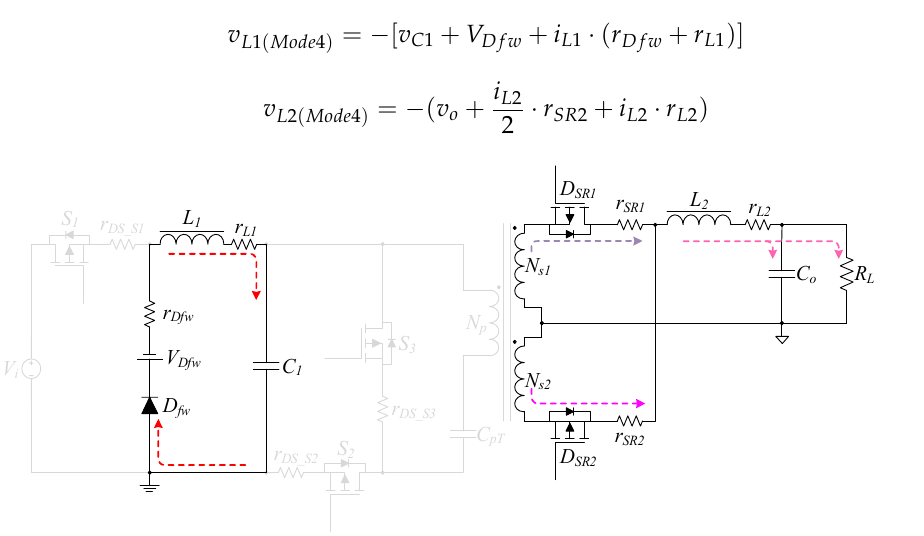
Figure 17. Equivalent circuit operating during [0.5 T , (0.5 + D ) T ]. Mode 4 [(0.5+ D ) T , T ]